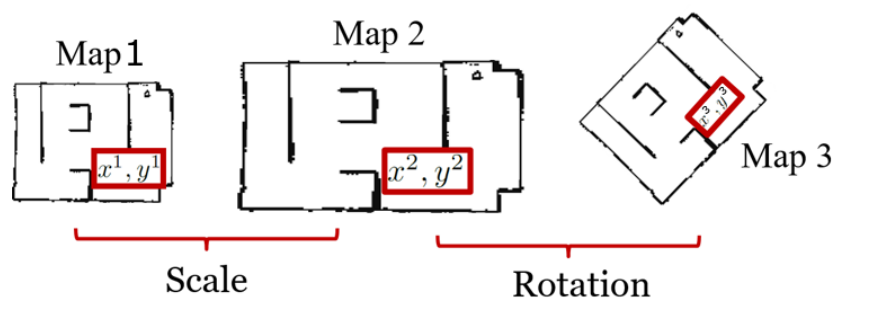
Figure 2. Correspondence problem due to the scale and rotational differences between maps.